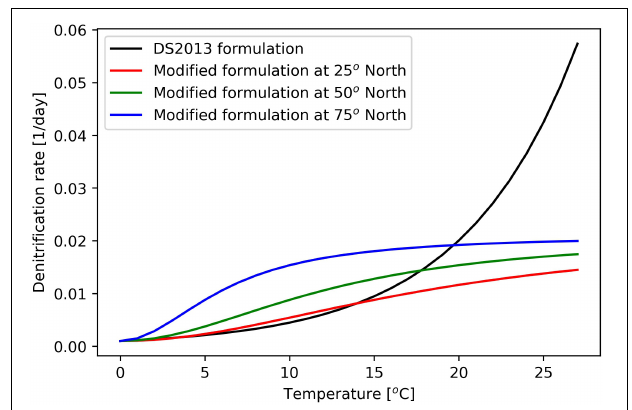
FIGURE 2 | Comparison of original and new formulation for